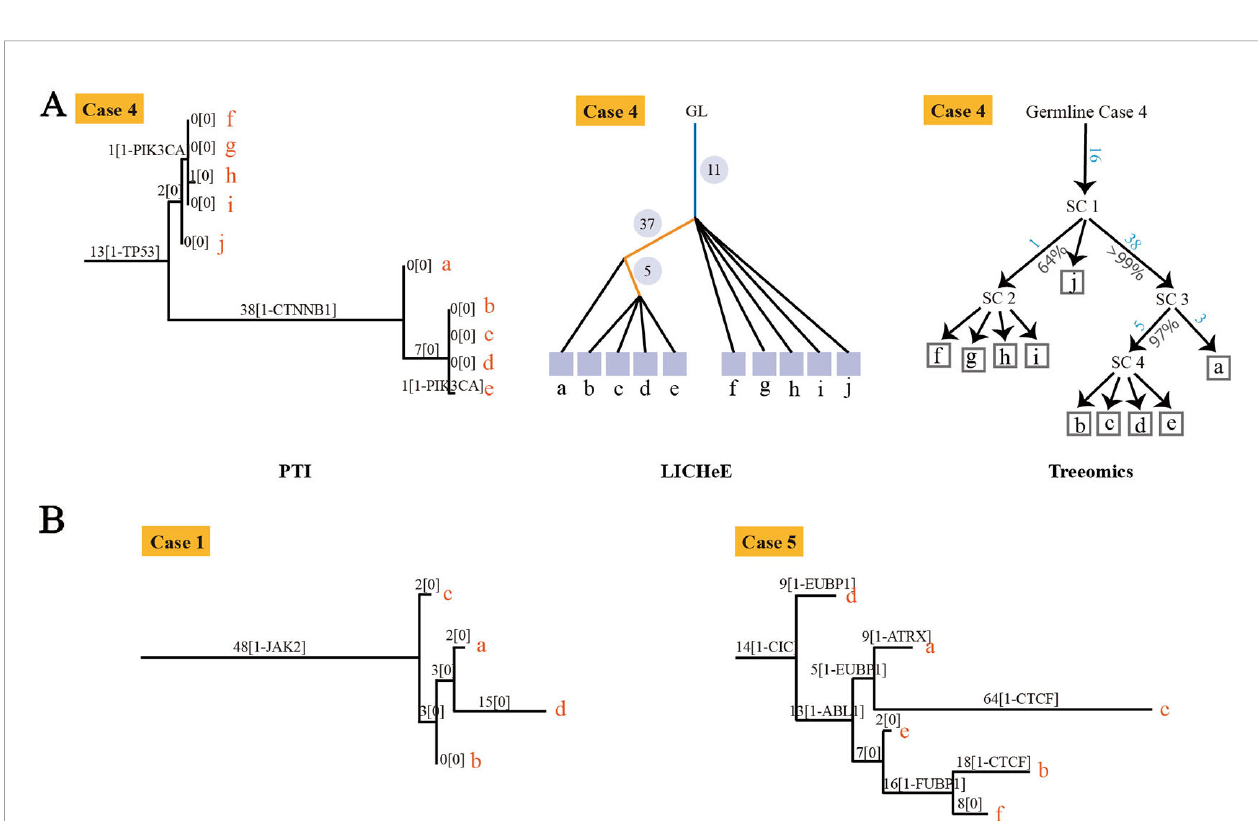
FIGURE 2 | The tree structures inferred by PTI for HGSC Cases 1, 4 and 5. (A) The tree structure of Case 4 inferred by PTI, LICHeE, and Treeomics respectively. In the LICHeE result: yellow line, internal branch; light blue line, trunk; black line, contribution link; the numbers inside the circle, SSNVs; the light purple square, tumor region. In the Treeomics result: numbers in blue correspond to the acquired variants in the branches. Percentages (gray) denote bootstrap values (1,000 samples). SC, subclone. (B) For Case 1, PTI fi rst separates the sample c to achieve the best branch split, which is same as the result of LICHeE. For Case 5, the tree structure inferred by PTI and Treeomics has high similarities using six samples and eight samples ( Supplementary Note 5 ).